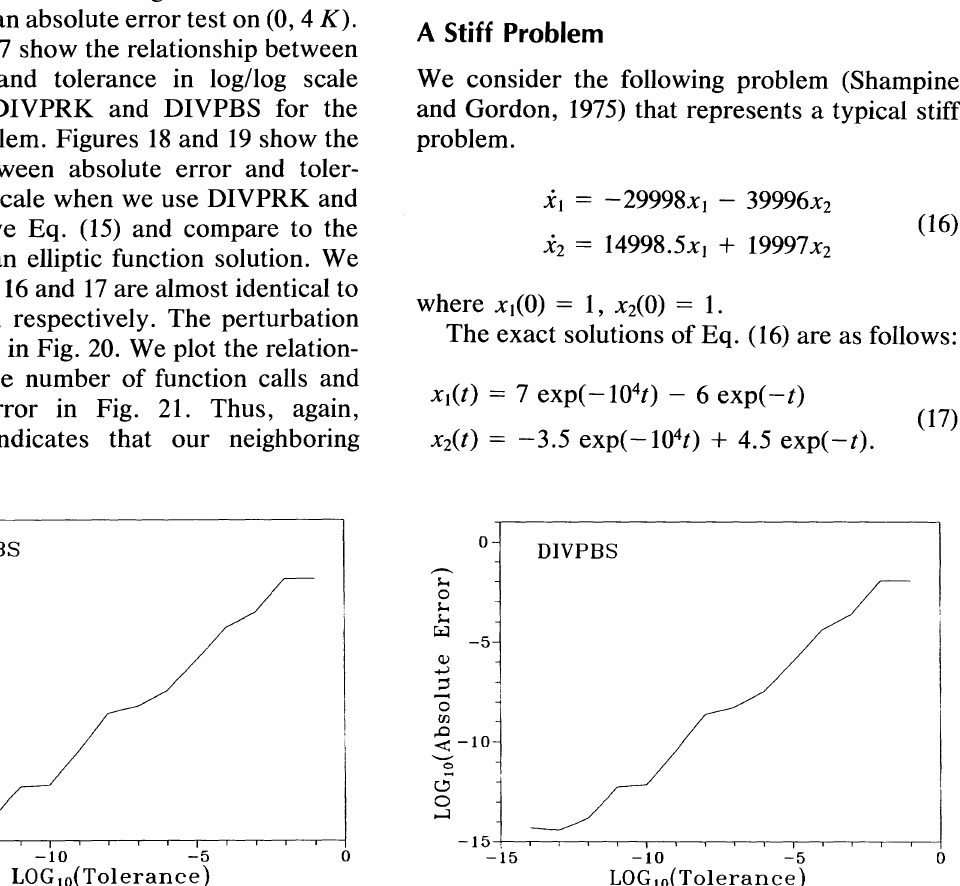
FIGURE 17 Absolute error vs. tolerance for the benchmark problem (DIVPBS).